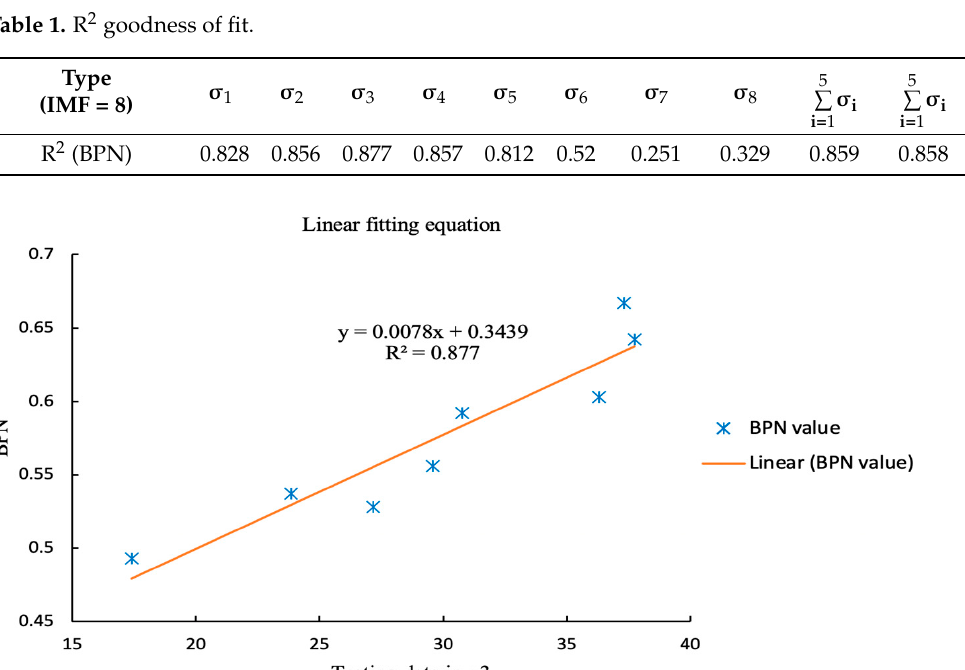
Table 1. R 2 goodness of fit.